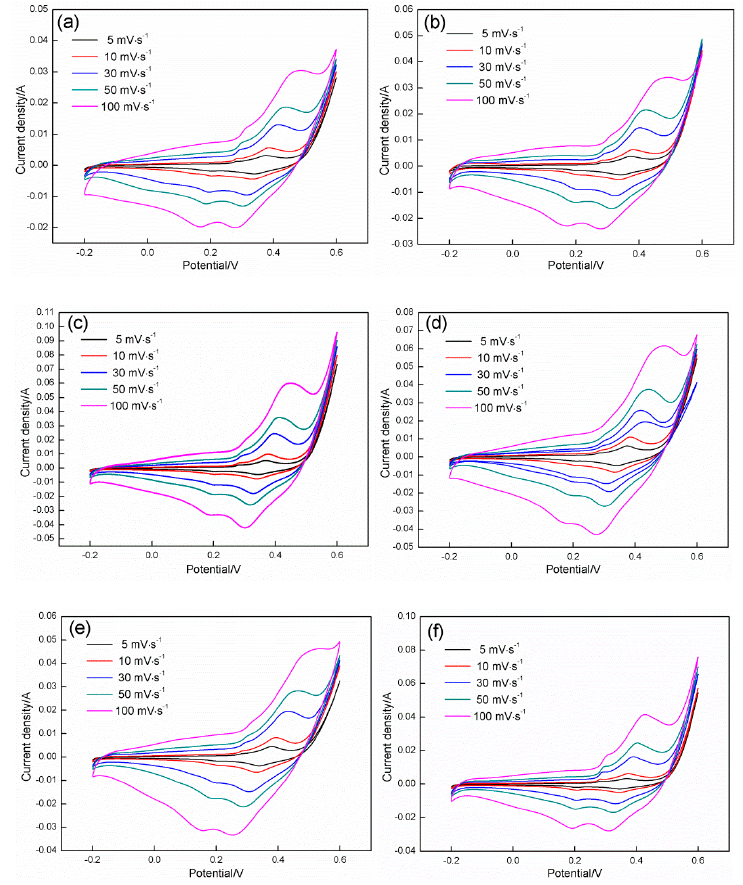
Figure 11. CV curves recorded on the samples at different scanning rates: ( a ) Sample A; ( b ) Sample B; ( c ) Sample C; ( d ) Sample D; ( e ) Sample E; ( f ) Sample F.